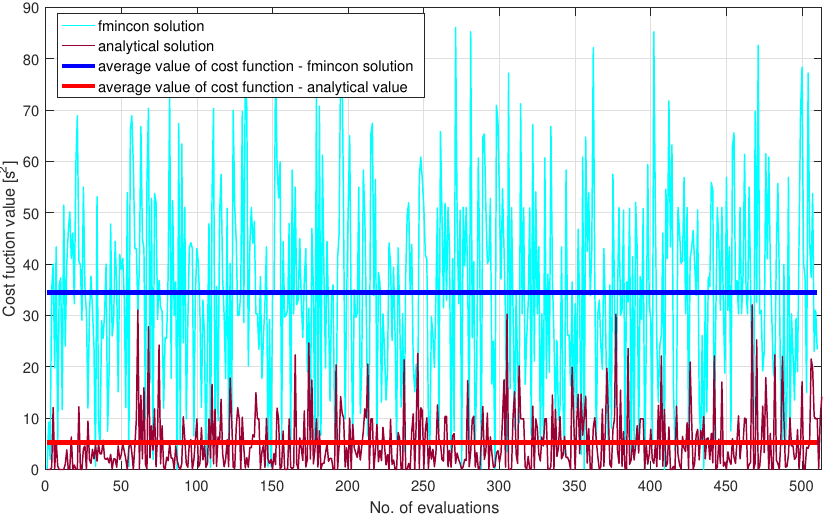
Figure 6. Values of the cost functions.